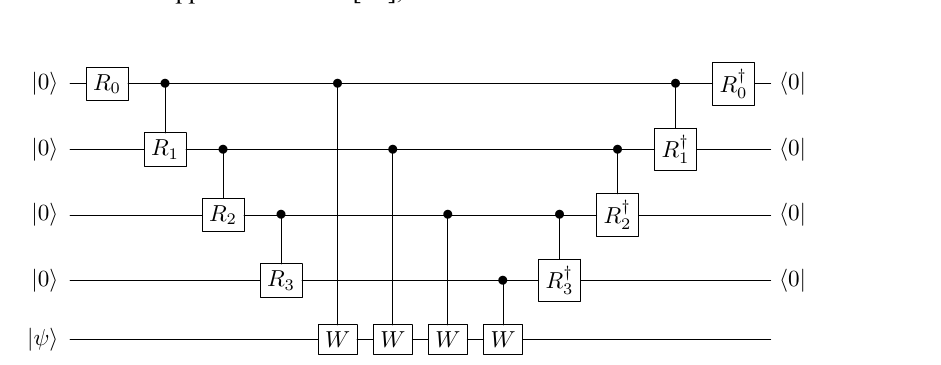
FIG. 4. A linear combination of steps using control registers prepared in unary using a linear sequence of controlled rotations. The state | ψ (cid:2) would be the state output by the adiabatic walk and W is used to indicate the final walk step W ( 1 ) from the adiabatic walk. In this example, the four control qubits would encode | j (cid:2) in unary and the rotations would prepare the amplitudes proportional to The rotations on the right invert this preparation. Given that the control qubits are measured in the state | 0 (cid:2) , the target will be in a state proportional to that given in Eq.